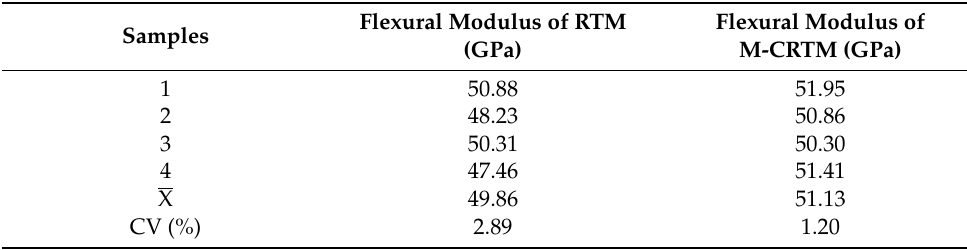
Table 2. Flexural modulus of RTM and M-CRTM samples.